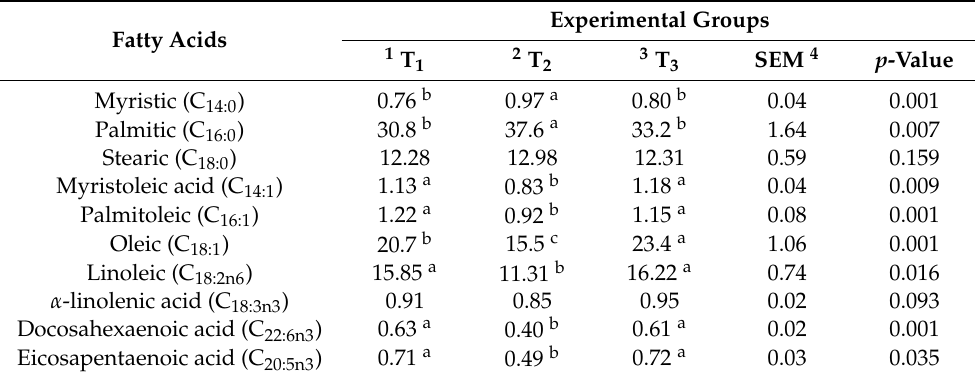
Table 3. Effect of dietary curcumin supplementation on fatty acid profile (g/100 g) of breast muscles in heat-stressed broiler chickens.